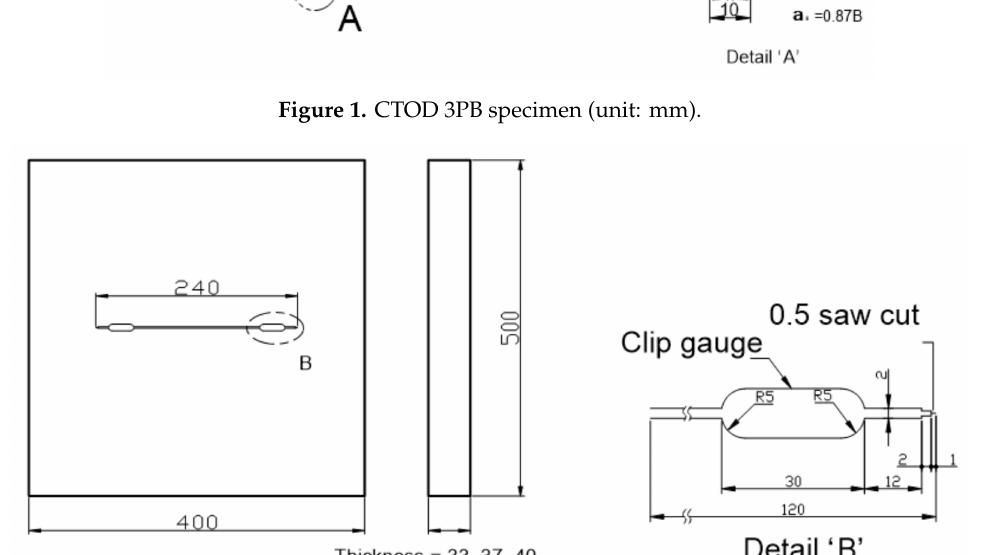
Figure 2. CTOD WP specimen (unit: